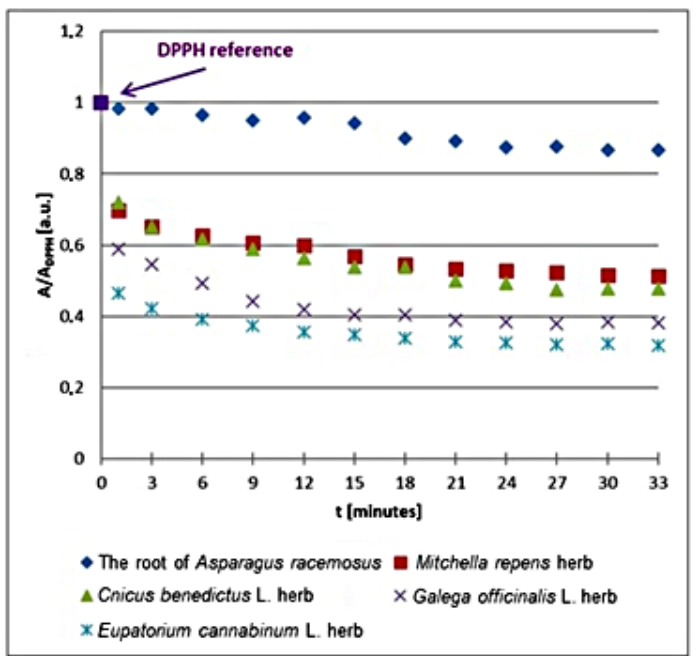
Figure 2. Changes of the relative amplitude (A/A DPPH ) of EPR spectra of DPPH free radicals with increasing time of interactions ( t ) with infusions of the root of Asparagus racemosus , Mitchella repens herb, Cnicus benedictus L. herb, Galega officinalis L. herb, and Eupatorium cannabinum L. herb. A—amplitude of the EPR line of DPPH free radicals in contact with the tested samples. A DPPH —amplitude of the EPR line of DPPH free radicals in the reference solution. For the reference solution, the relative amplitude (A/A DPPH ) takes the value of 1. Data for the infusions obtained from the plant materials not exposed to UV radiation.